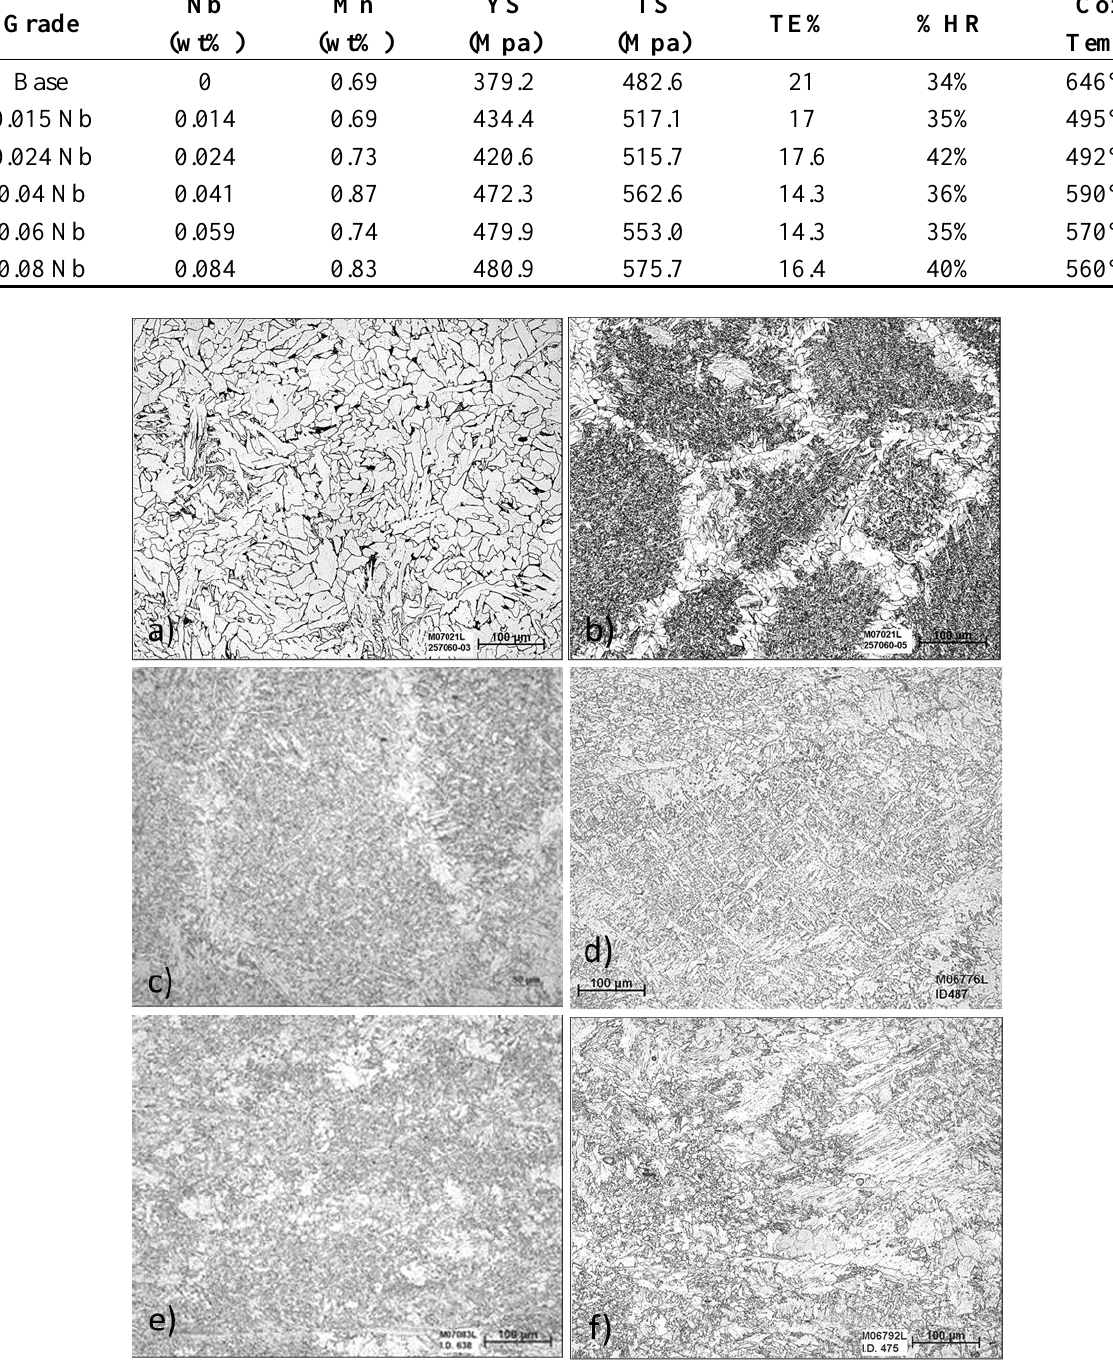
Figure 15. Microstructures from CASTRIP production samples for ( a ) Base grade at high coiling temperature (air cooled on run-out-table), showing ferritic microstructure, ( b ) Base grade at high cooling rate on the run-out-table, coiled at 505 °C, showing allotriomorpic ferrite at PAGB and AF, ( c ) 0.015% Nb coiled at 515 °C, very little allotriomorpic ferrite at PAGB and AF, ( d ) 0.024% Nb coiled at 534 °C, bainite, ( e ) 0.04% Nb coiled at 590 °C, bainite and ( f ) 0.08% Nb coiled at 560 °C,